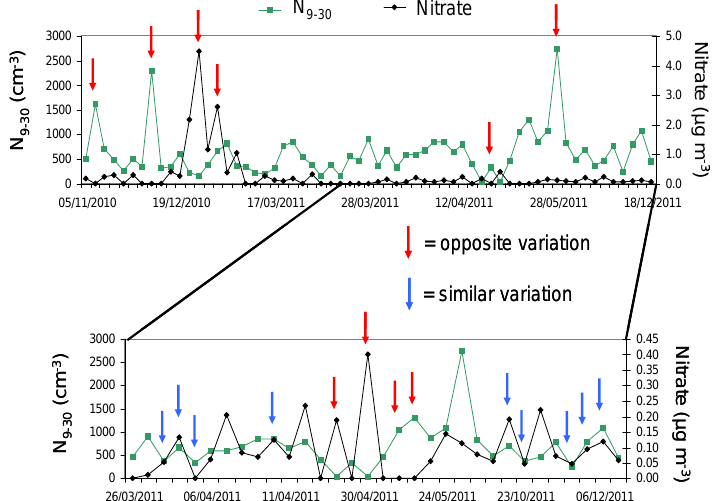
Fig. 7. Time variation of nitrate concentration (µgm − 3 ) and particle number concentration (cm − 3 ) of the nucleation mode (N 9 − 30 ) for the entire measurement period (above graph) and for a section of the data (below). Red arrows highlight opposing variations in concentrations and blue arrows indicate similar variations in concentrations. Table 2. Factors/sources and factor loadings ( < 1) identified by applying Principal Component Analysis on a dataset composed of PM 1 chemical components, particle number concentration for different size ranges, gaseous pollutant concentrations and some meteorological